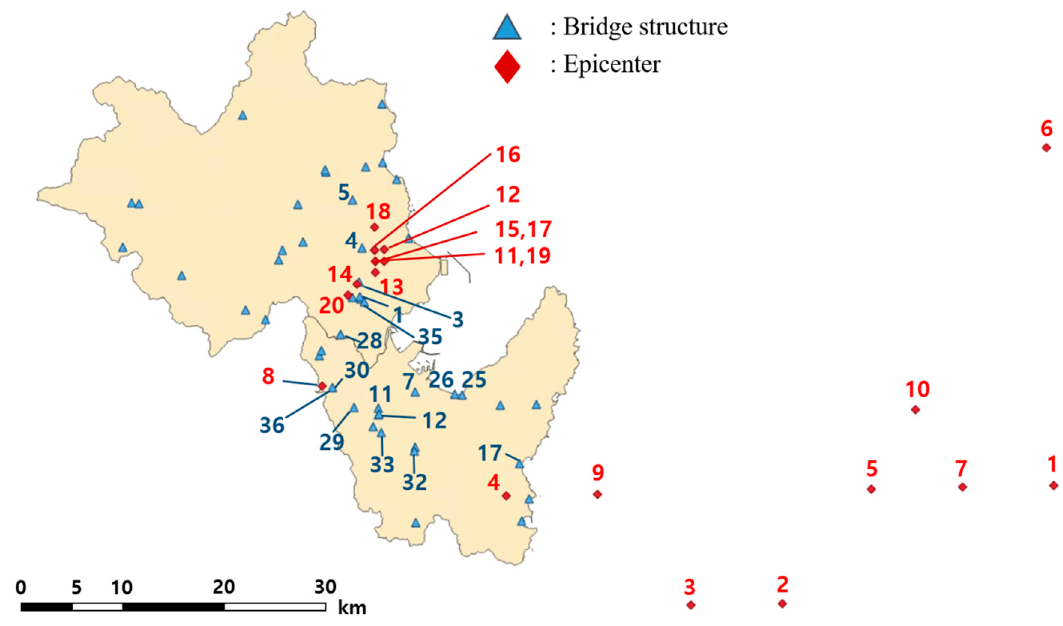
Figure 5. Locations of the considered bridge structures and epicenters in the target network.